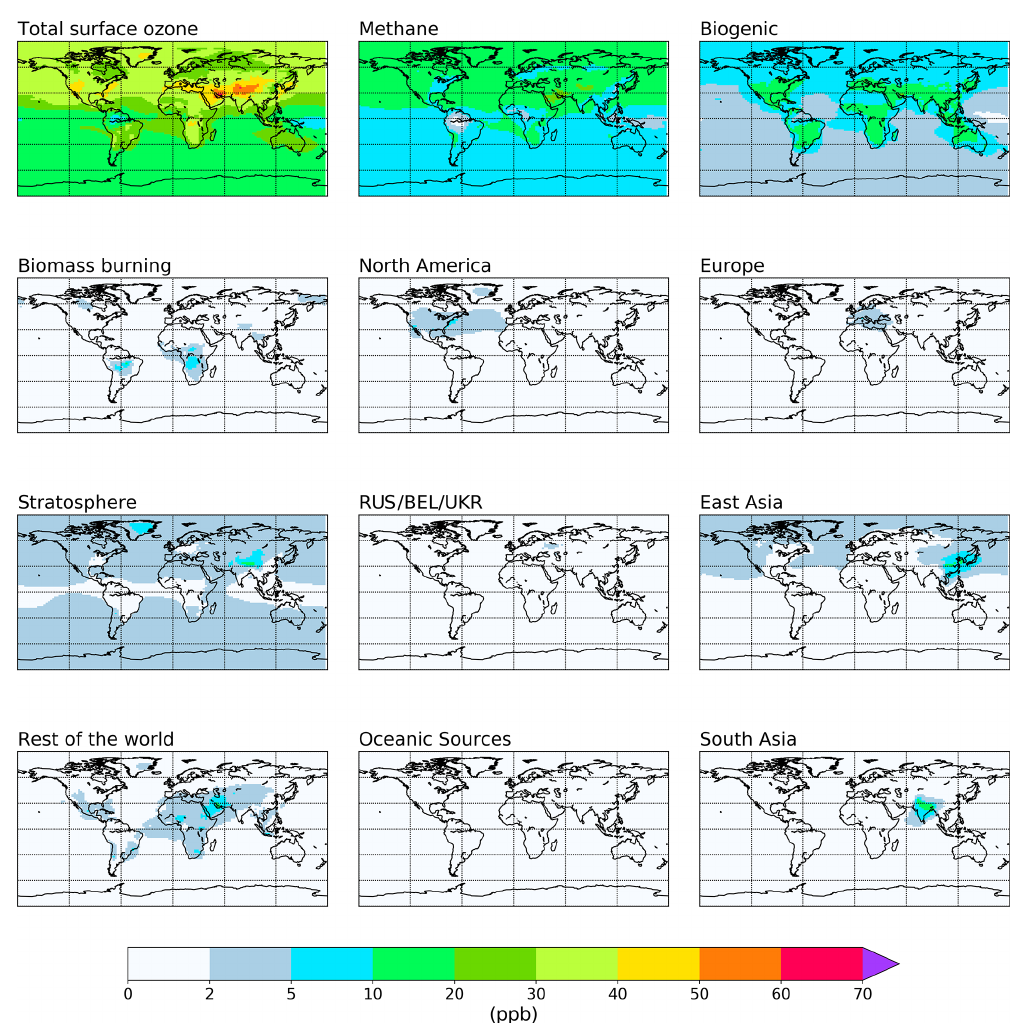
Figure 3. Annual mean surface ozone (ppb) from the VOC-tagged base run. Total ozone is shown in the top left panel. Tagged ozone tracers are shown in the other panels. “RUS/BEL/UKR” refers to Russia, Belarus, and the